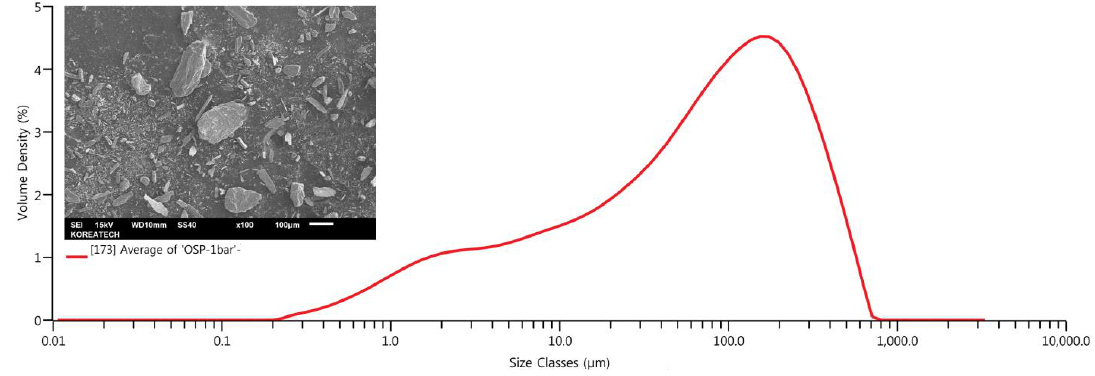
Figure 3. Typical particle size distribution for oyster shell powder (OSP) after dry ball milling process. Table 3. Particle-size distribution (PSD) data of oyster shell powder (OSP) achieved using a dispersive air pressure 1 bar.